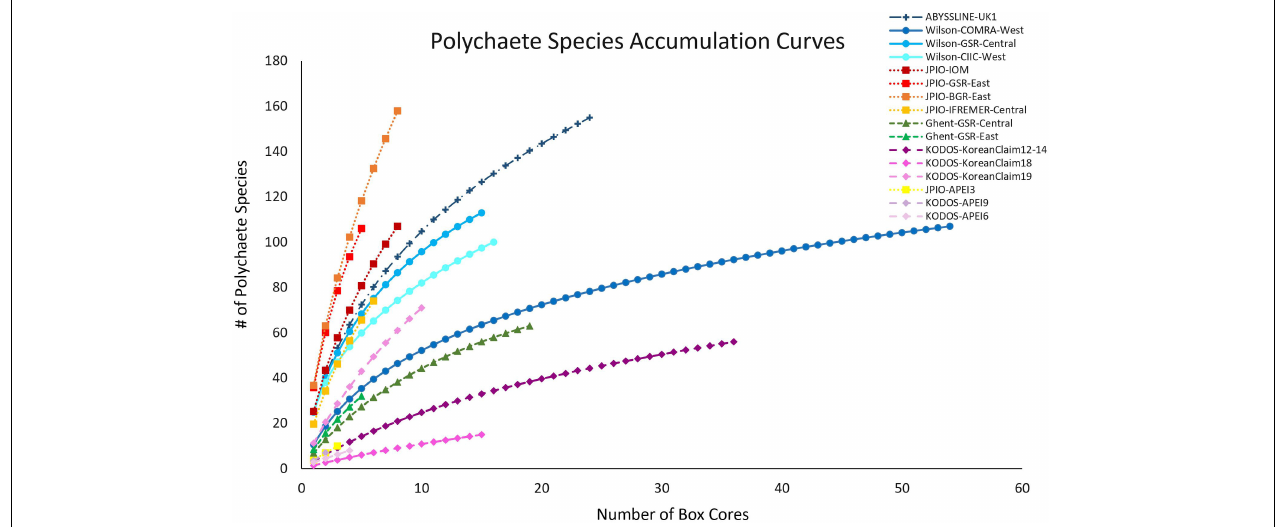
FIGURE 4 | Mean polychaete species accumulation as a function of number of box-core samples (UGE plot from EstimateS, 100 permutations) at different sites in the CCZ region. Note that KODOS-KoreanClaim data come from a single site sampled in different years. Data sets that are considered to have been sampled with similar protocols and to have used a consistent taxonomy are indicated by similar